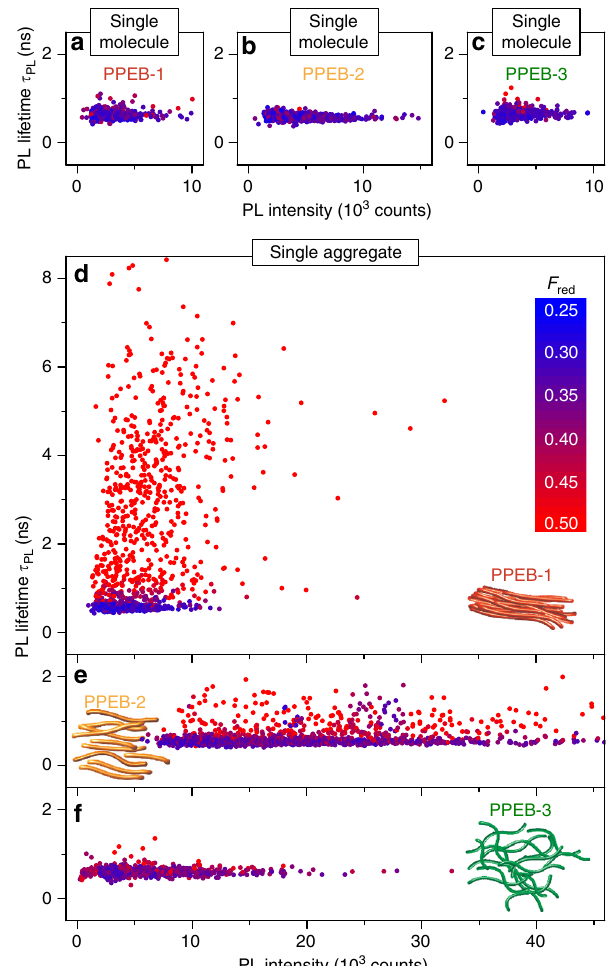
Fig. 5 Comparison of the statistics of single chains and aggregate samples. a – c Scatter plots of PL lifetime, τ PL , and PL intensity for single chains and isolated aggregates d – f formed by SVA of the three materials measured in air. The color encodes the fraction of red emission, F red , for each measured single particle, which ranges between 0.25 (blue) and 0.5 (red). Data from 391 a , 694 b , and 469 c single chains and 1196 d , 1881 e , and 889 f isolated aggregates are